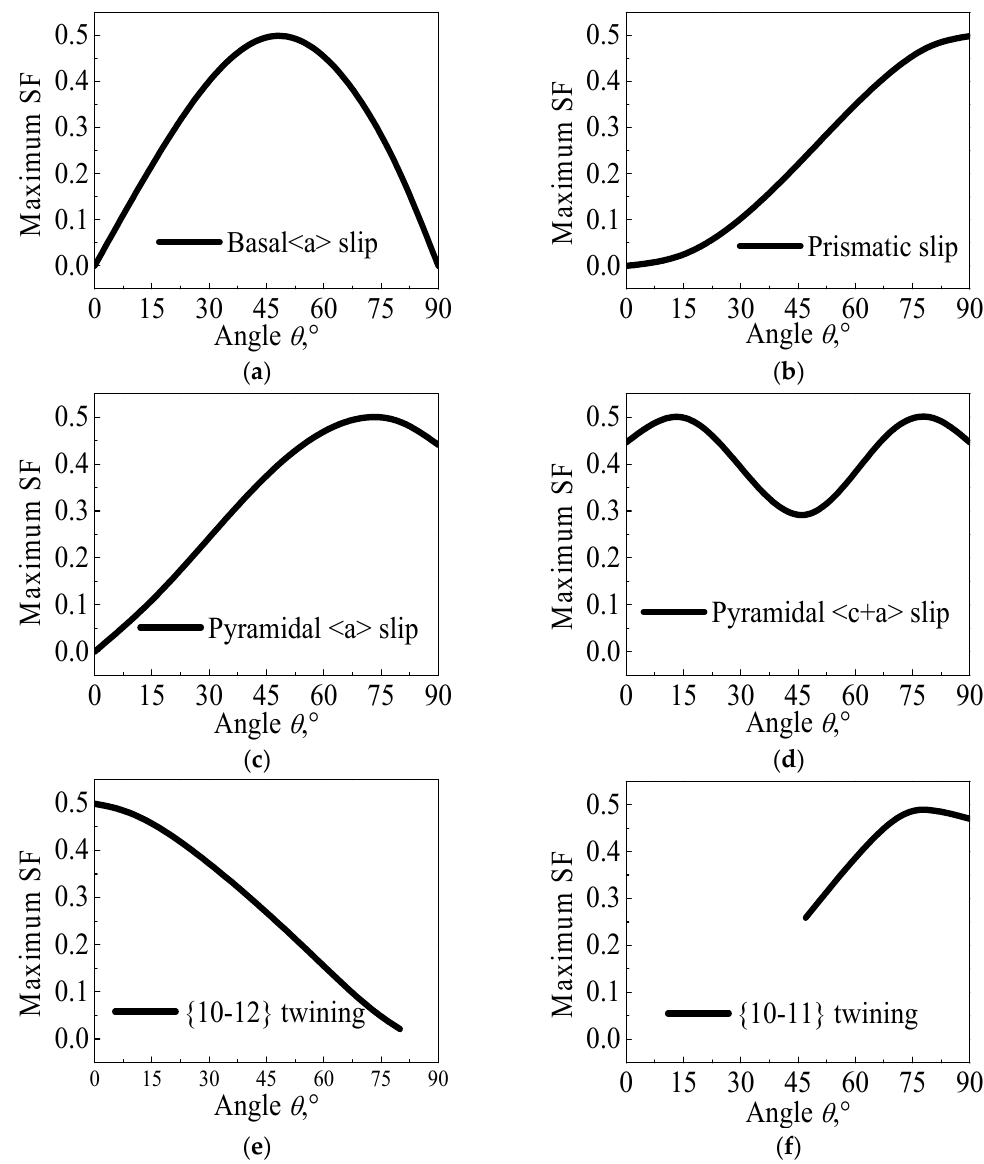
Figure 6. θ -maximum SF curves under different microstructure deformation mechanisms, ( a ) basal <a> slip, ( b ) prismatic slip, ( c ) pyramidal <a> slip, ( d ) pyramidal <c + a> slip, ( e ) (cid:8) (cid:9) twinning, ( f ) 1011 contraction